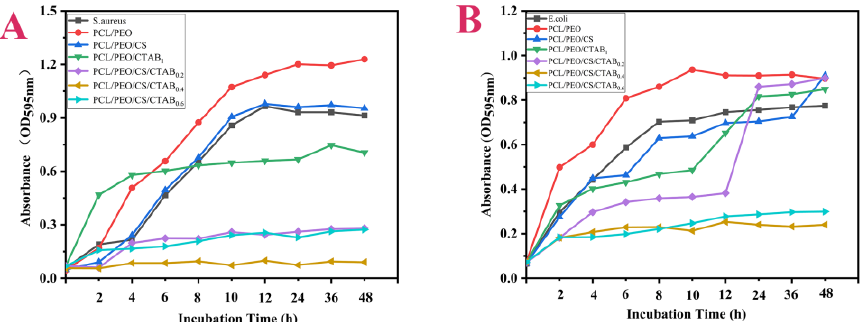
Figure 10. Inhibitory growth curves of composite spinning films: ( A ) E. coli ; ( B ) S. aureus .